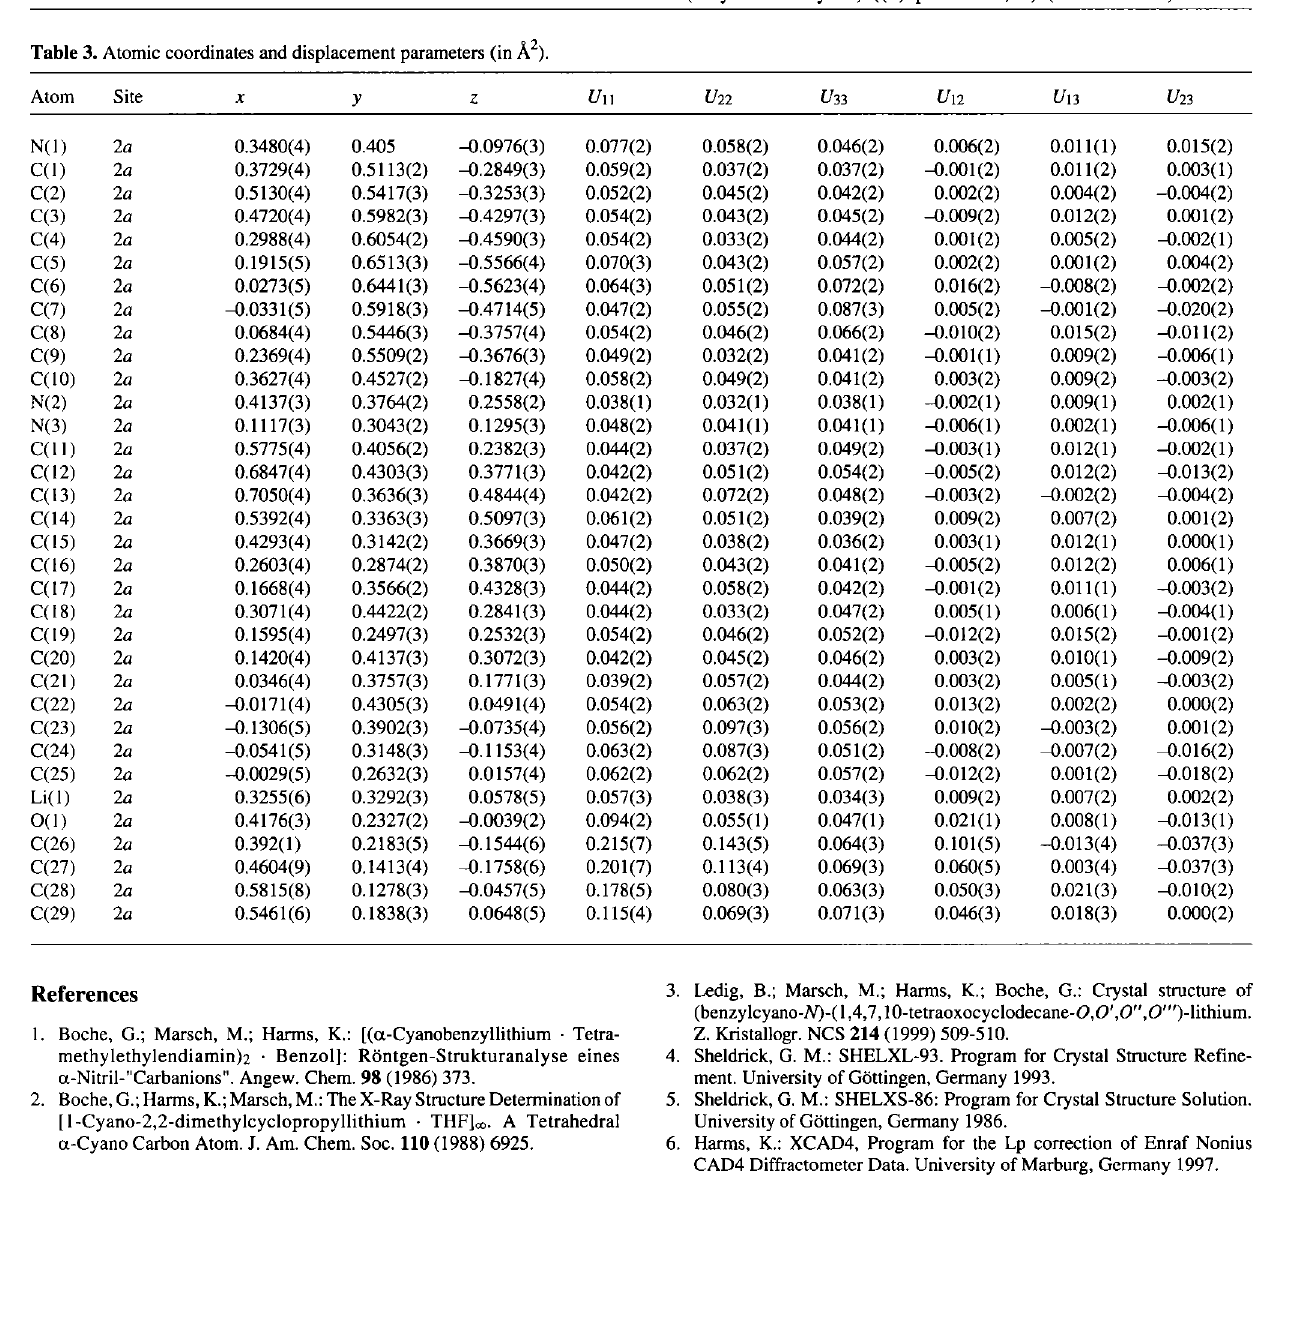
Table 3. Atomic coordinates and displacement parameters (in Ä 2